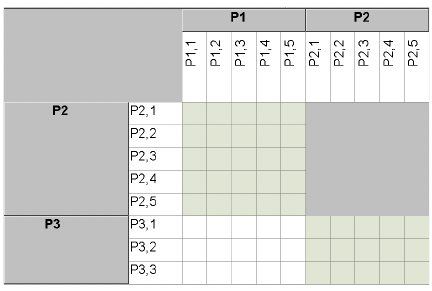
Figure 3: Cross-consistency matrix for the 3-parameter “Zwicky